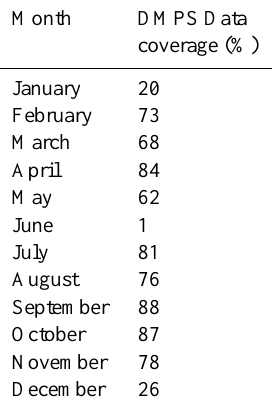
Table 1. Data coverage of DMPS aerosol distributions during the year